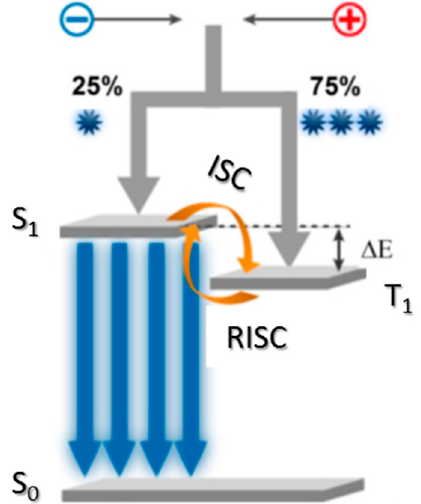
Figure 1. Schematic representation of thermally activated delayed fluorescence (TADF) process.